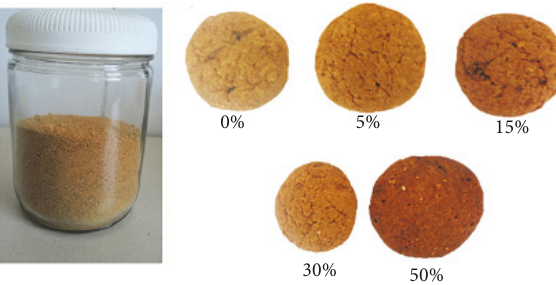
Figure 3: CAB flour and cookies with different